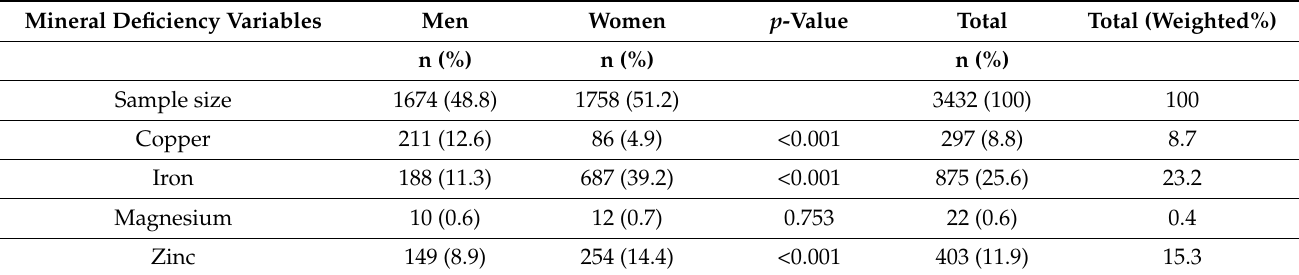
Table 3. Prevalence of mineral deficiencies among Saudi